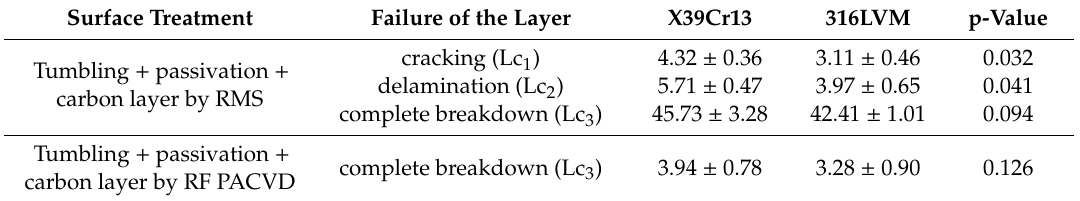
Table 5. Results of comparative adhesion of the carbon layer, indenter load F n [N], to the substrates. Surface Treatment